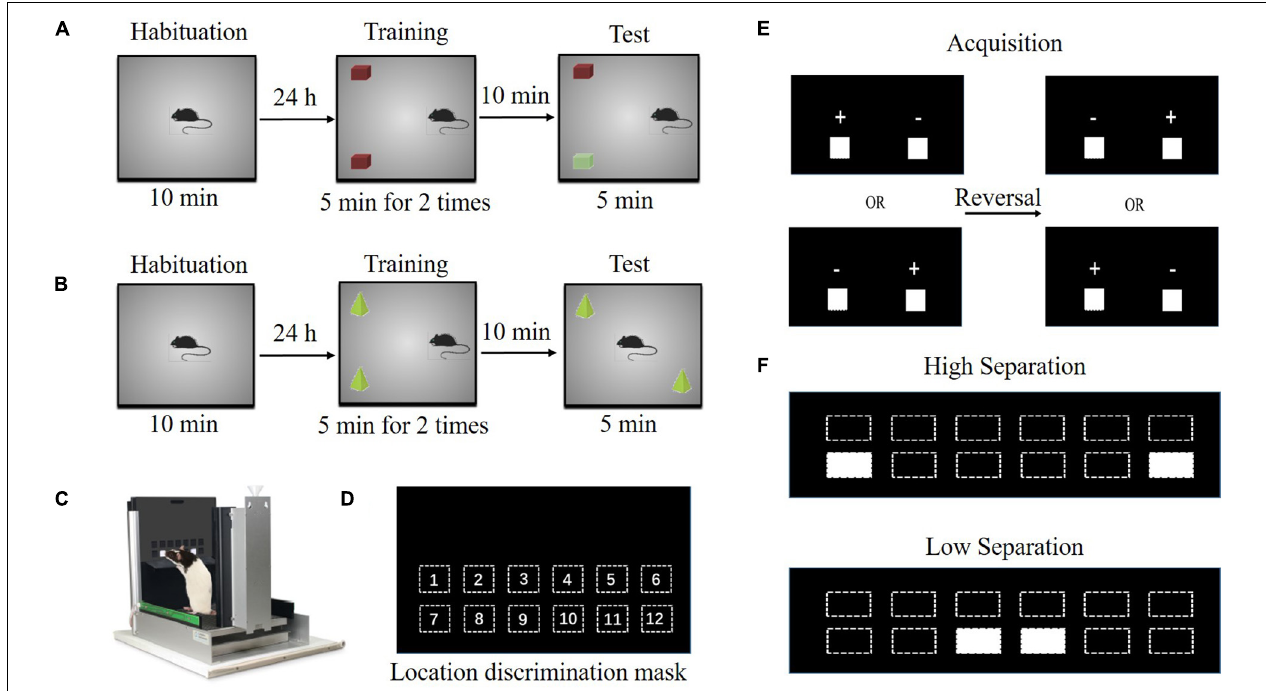
FIGURE 2 | Schematic of cognitive-behavioral tests. (A) The paradigms of novel object recognition. (B) The paradigms of novel location recognition. (C–F) The paradigms of location discrimination (LD). (D) The mask of LD with 12 locations is depicted. (E) The LD training phase is shown with two response windows illuminated at medium separation. If a mouse makes seven correct responses in eight consecutive trials, the reward-location contingency is reversed . (F) Two difficulty levels are depicted in the LD